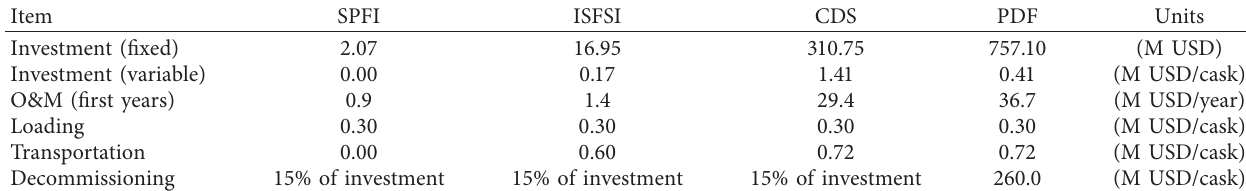
Table 9: Normalized cost categories for SFPI and ISFSI facility options from year 2014 forward to 2020.